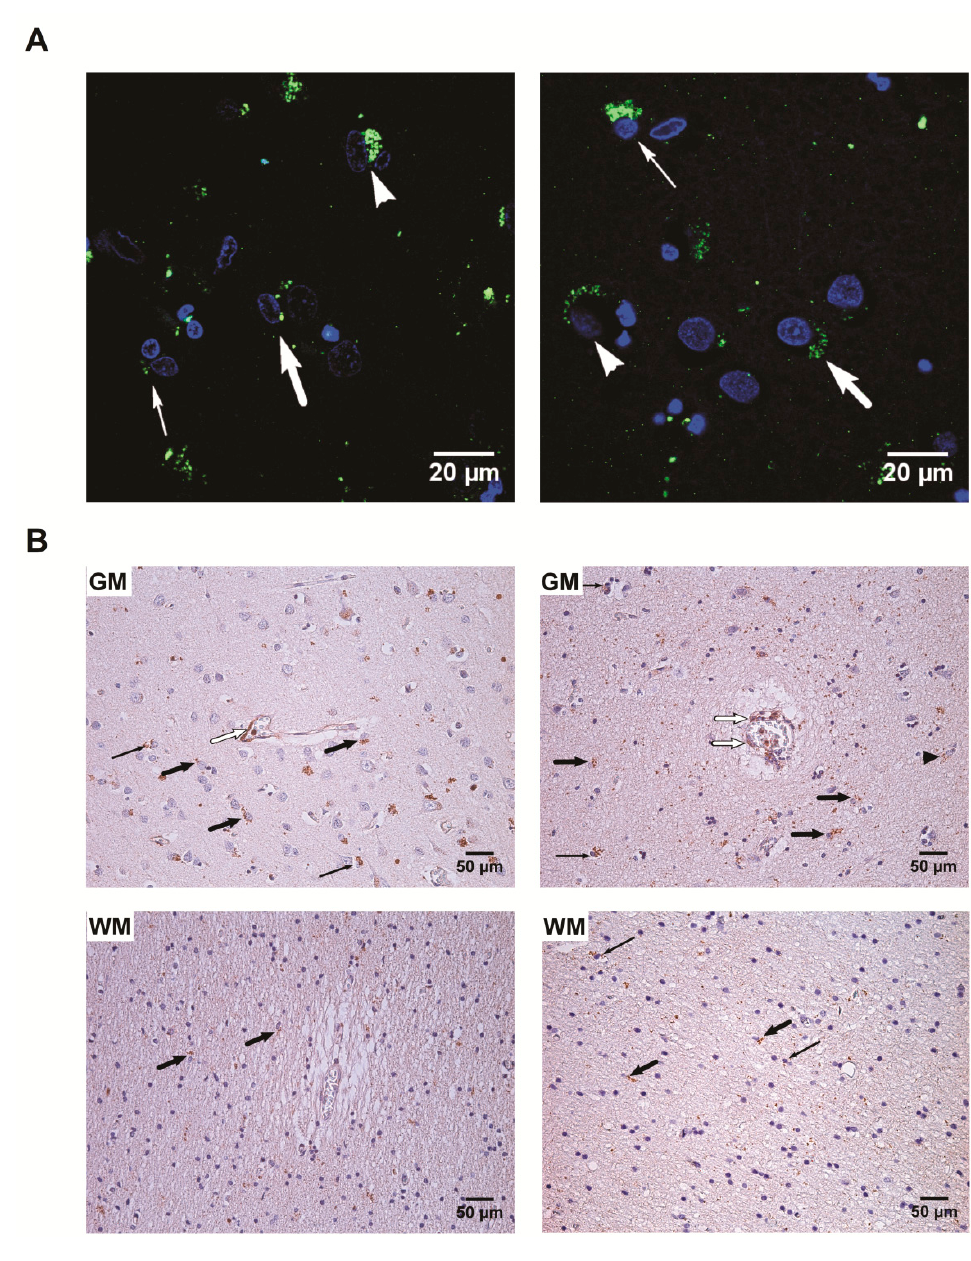
Figure 6. The presence of herpesvirus-7 (HHV-7) positive cells in the PCR+ samples: ( A ) detection of HHV-7 antigens by immunofluorescence, confocal microscopy (1000 × ), DAPI—blue, HHV-7 immunopositive products—green. Left: frontal gray matter—HHV-7 positive neuron (arrowhead), astrocyte (thick arrow), oligodendrocyte (narrow arrow) of the unspecified encephalopathy (UEP) subject; right: temporal gray matter—HHV-7 positive neuron (arrowhead), astrocyte (thick arrow), oligodendrocyte (narrow arrow) of the UEP subject; (B ) detection of HHV-7 antigens by routine immunohistochemistry (IHC), HHV-7 immunopositive products—brown. Left: frontal gray (GM) and white (WM) matter of the UEP subject, astrocytes (black thick arrow), oligodendrocytes (black narrow arrow), vascular bed with positive mononuclear cell in the lumen (white thick arrow), (250 × , 250 × ); right: temporal gray (GM) and white (WM) matter of the UEP subject, neuron (arrowhead), astrocytes (black thick arrow), oligodendrocytes (black narrow arrow), vascular bed with positive mononuclear cell in the lumen (white thick arrow), (250 × , 250 × ). An increased total number ( p < 0.001) of CD68 positive cells was detected in the white matter of the frontal and temporal lobes of the UEP group in comparison with